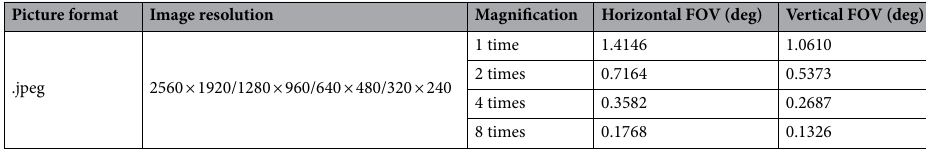
Table 1. Parameters of telescope camera built in Leica TM50